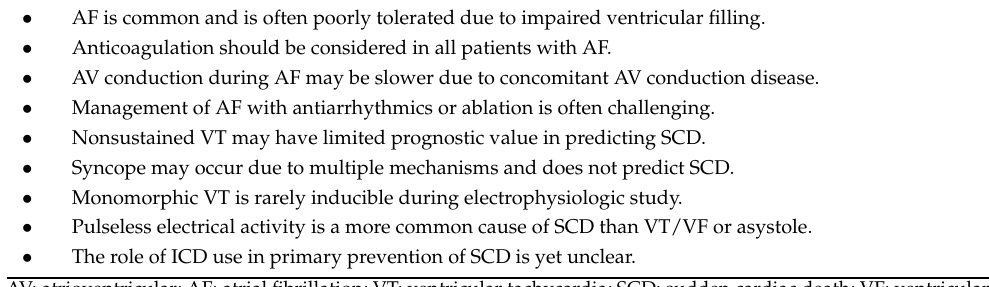
Table 1. Typical arrhythmia characteristics in patients with cardiac amyloidosis.